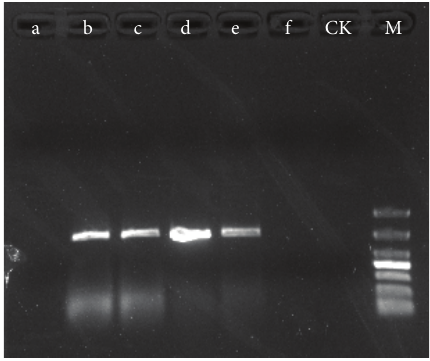
Figure 3: Reverse transcriptase PCR amplification of the partial hsp gene. Lane a: noninoculated reactor on the 20th day; Lane b– f: inoculated reactors with initial pH 5.0, 6.0, 7.0, 8.0, and 9.0 on the 20th day, respectively; Lane CK: original activated sludge at 0 day; Lane M: DL 1000